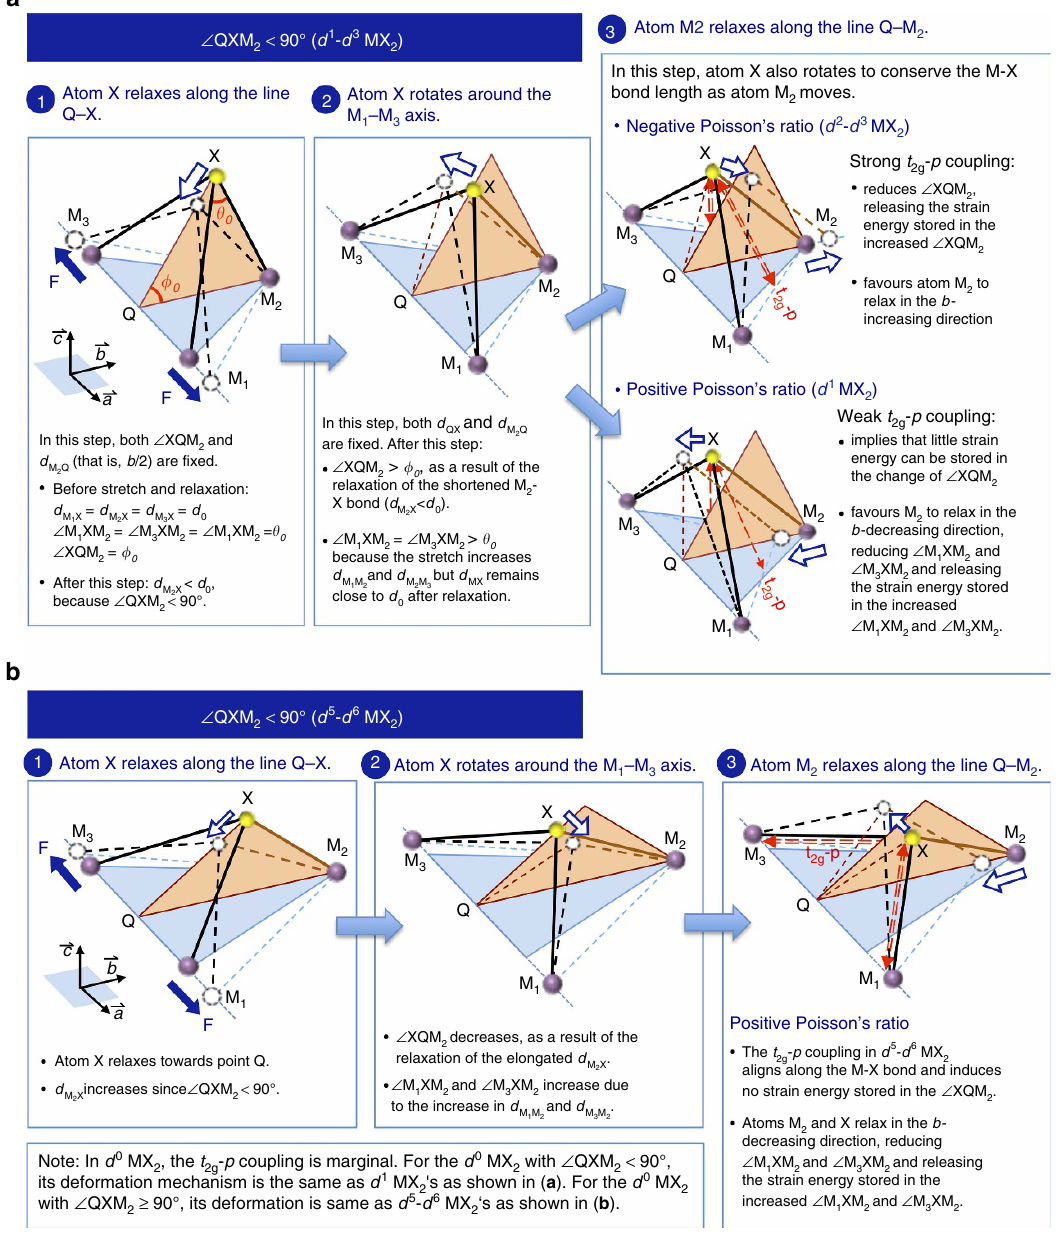
Figure 4 | Deformation mechanism. The solid and dashed M–X bonds indicate, respectively, the initial and final configurations at each relaxation step. The force is applied along the lattice- a direction. The red dashed arrows indicate the direction of the t 2g -p orbital interaction. The hollow blue arrows show the resulting movement of the X and M 2 atoms within the Q–X–M 2